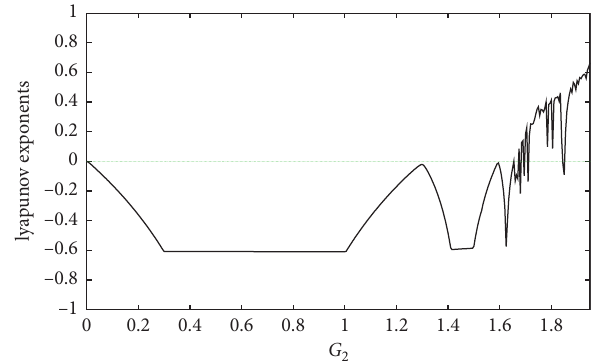
Figure 4: Maximum lyapunov exponent